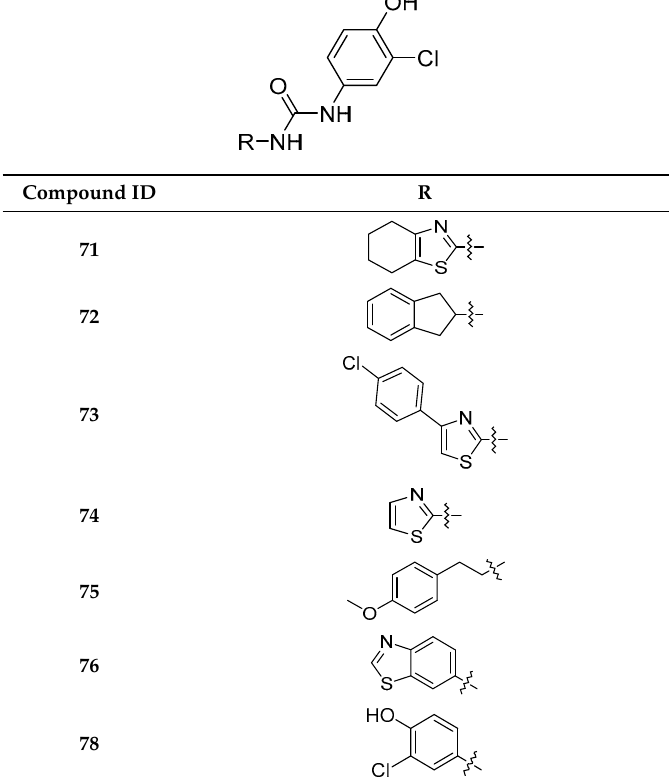
Table 4. Fourth series of prepared compounds ( 71 – 78 ).